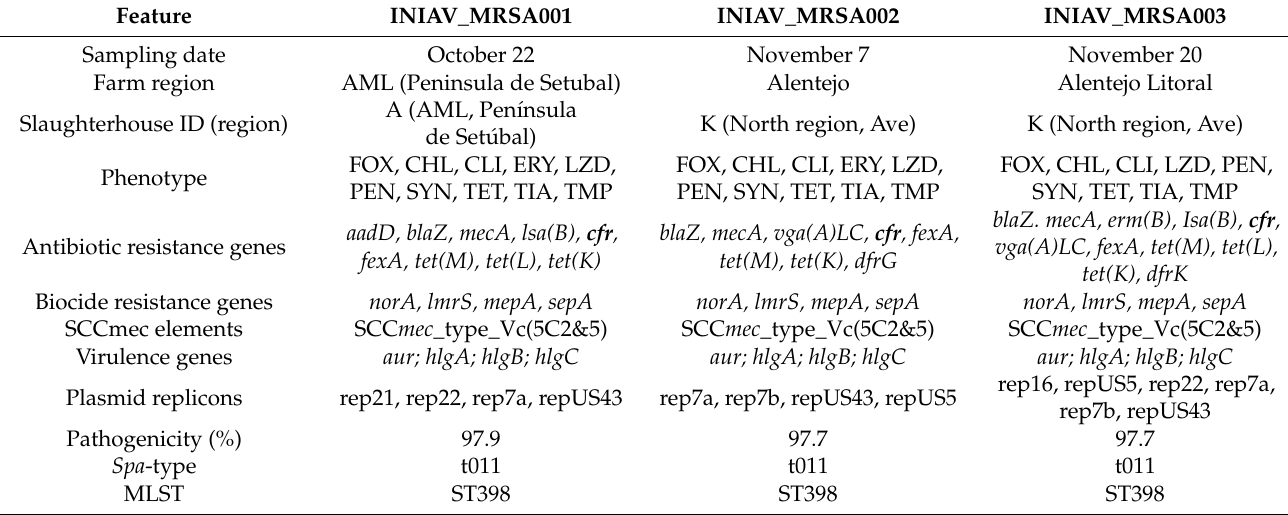
Table 2. Whole-genome characterization of linezolid-resistant MRSA ( n =